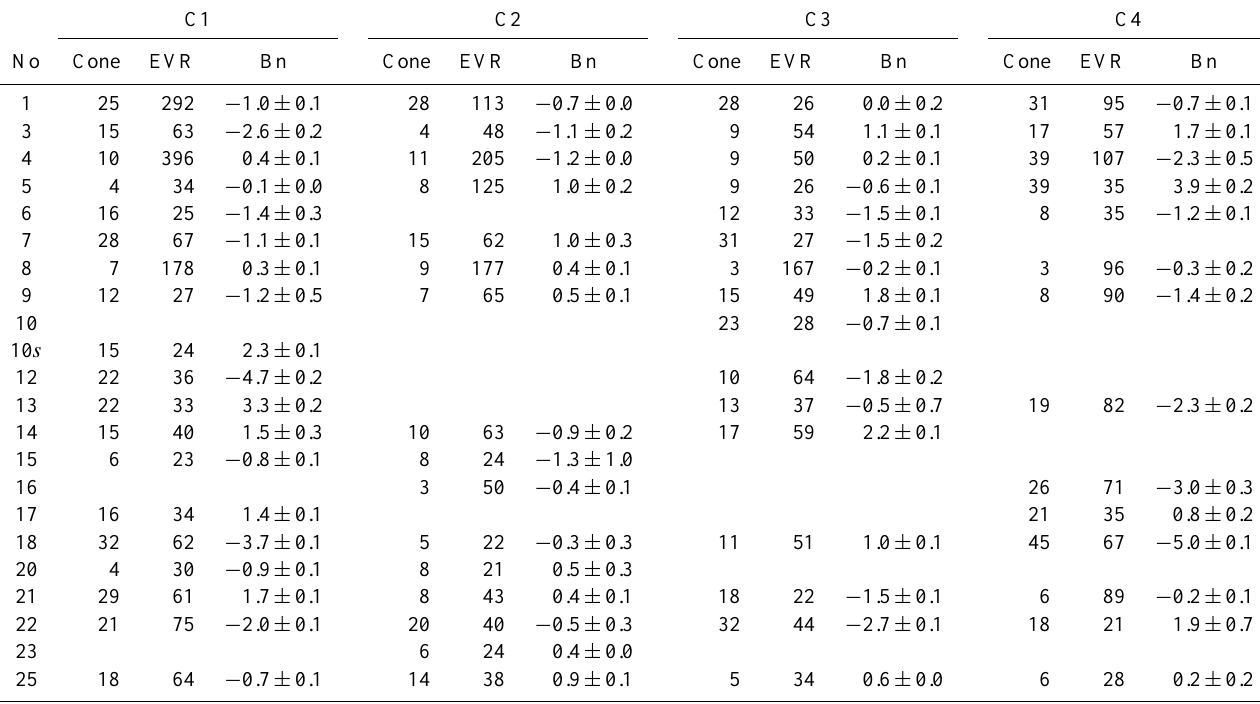
Table 2. Arc-polarized structures: four-spacecraft